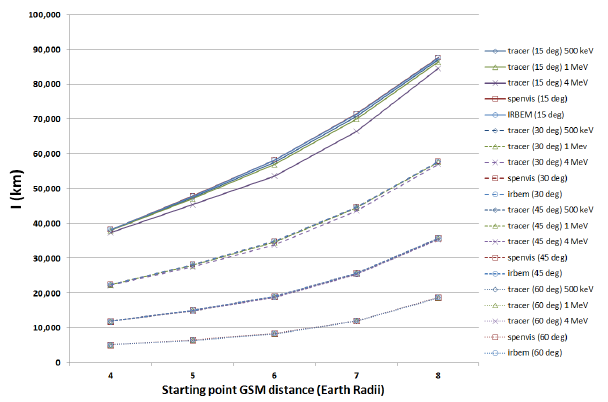
Figure 2. Calculations of I as a function of initial distance (in R E ) at 00:00MLT, for pitch angles of 15, 30, 45 and 60 ◦ and quiet solar wind